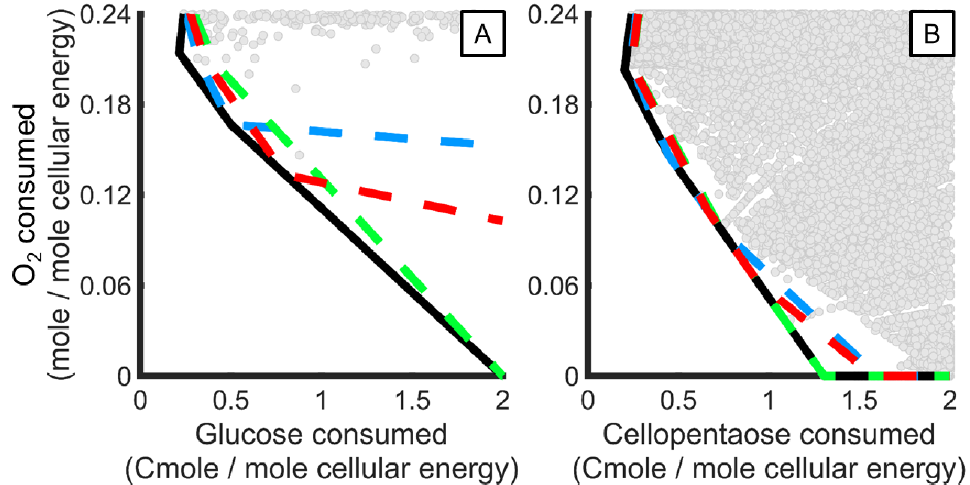
Figure 3. Metabolic strategies for cellular energy production from glucose ( A ) and cellopentaose ( B ) that minimize resource utilization span between complete oxidation and fermentation. Overall optimal O 2 and carbon source utilization strategies for cellular energy production are highlighted with black boundaries. All possible metabolic strategies (elementary flux modes) are grey points. Metabolic strategies that produce only acetate (blue dashed line), acetaldehyde (red dashed line), or ethanol (green dashed line) are highlighted.